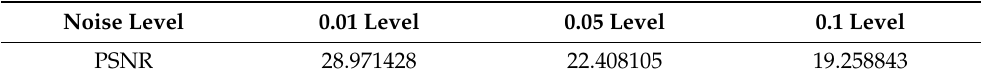
Table 7. PSNR for noise